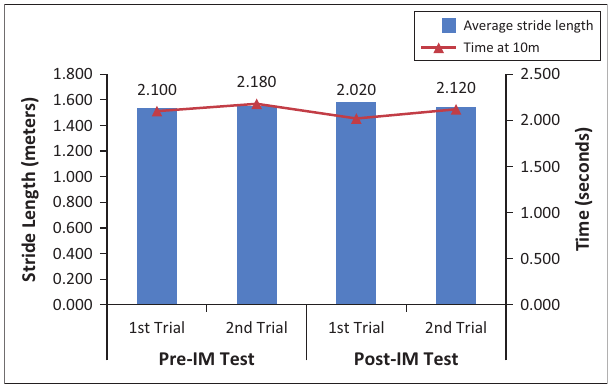
FIGURE 6: Effect of stride frequency within the acceleration phase, on time at 10 m.